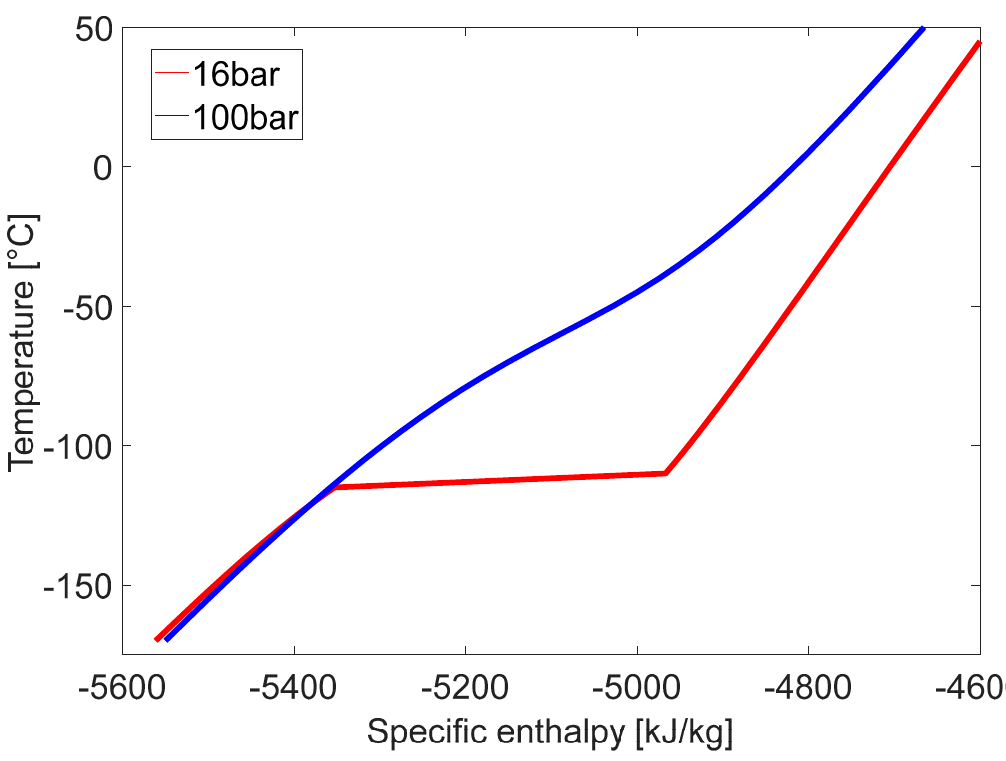
Figure 6. Temperature–enthalpy diagram of the BOG at 16 bar and 100 bar.